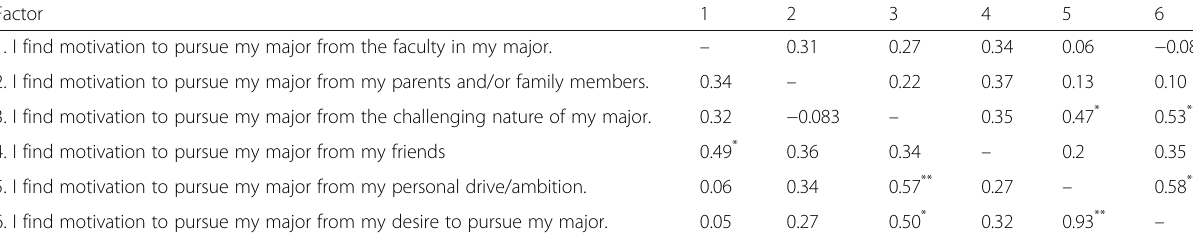
Table 10 Correlations for motivations to pursue STEM majors